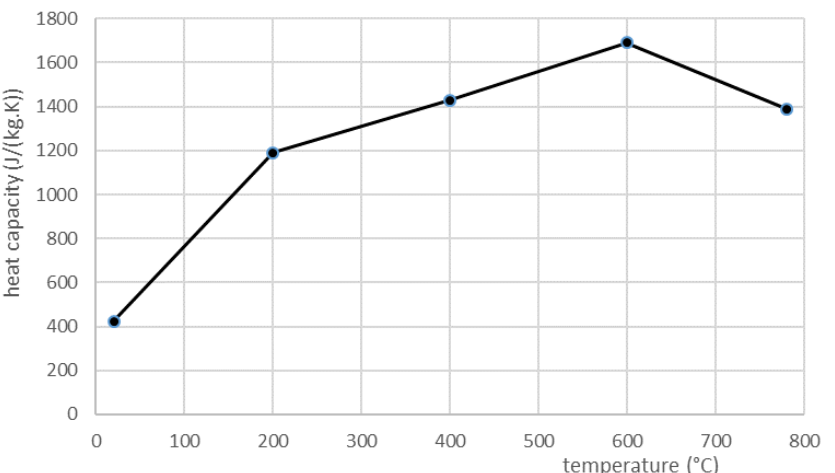
Figure 5. Change in specific heat capacity c [J/kg cdot K] for cementitious composite CC1 depending on ambient temperature